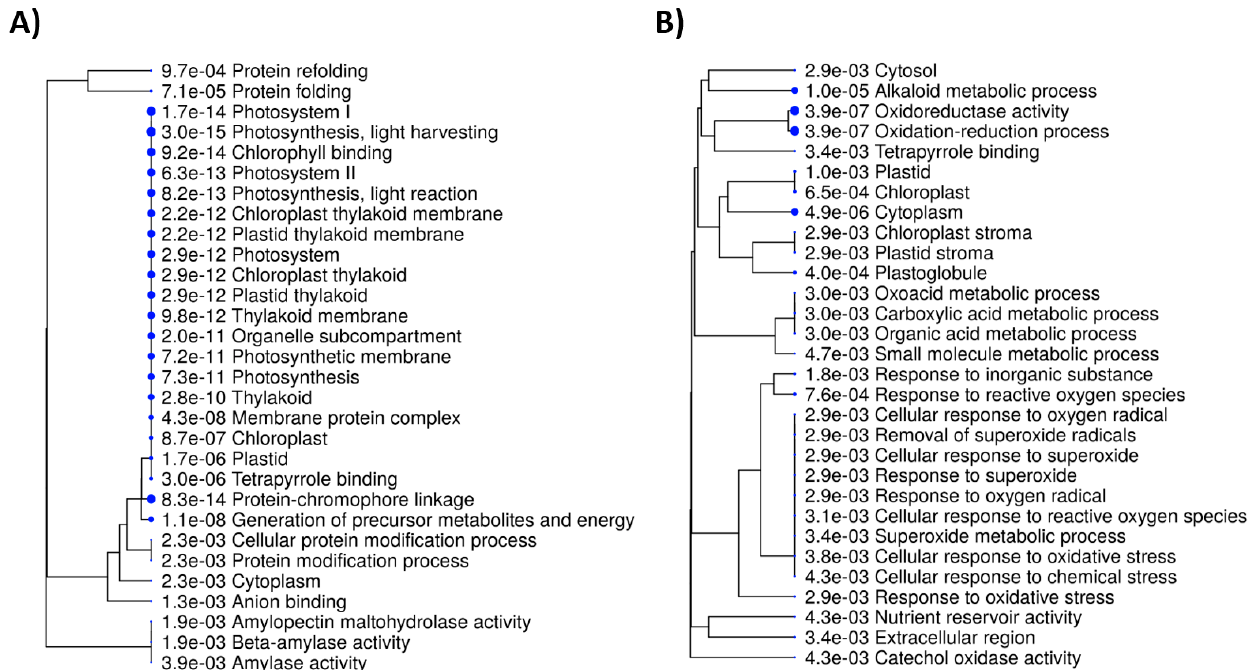
Figure 4. Enriched metabolic pathways under the drought condition in germinating Papaver somniferum plants. A hierarchical clustering tree summarizing the correlation among significant metabolic pathways. Pathways with many shared genes were clustered together. Bigger dots indicate more significant p -values. ( A ) DEGs, ( B ) DEPs. The plots were produced using ShinyGO webserver (http://bioinformatics.sdstate.edu/go/, accessed on 18 August 2021) [40].